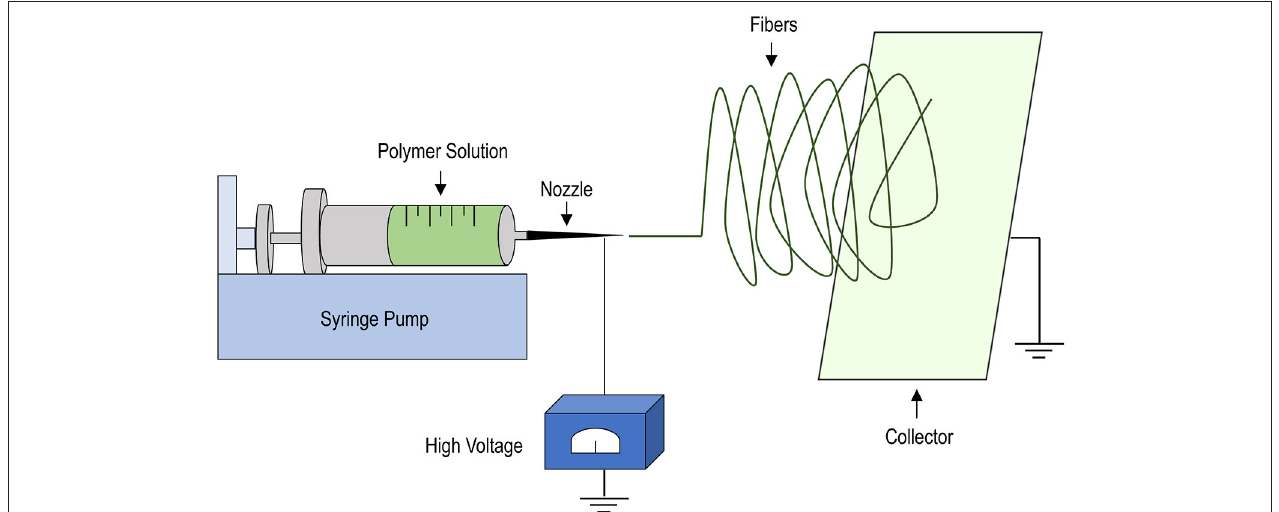
FIGURE 2 | Schematics of the electrospinning procedure. A liquid polymer solution is loaded into a syringe mounted into a syringe-pump and set to flow at defined rates through a nozzle of variable diameters (depending on the operational needs). The application of strong electric field allows the polymer to deposit onto a collector, consisting of a rotating mandrel or, as shown, a rotating plate onto which a non-woven scaffold can be manufactured due to solvent evaporation and solidification of the polymer fibers. Scaffold properties, such as porosity, fiber dimension and thickness can be easily adjusted by varying the dimension of the nozzle, the extrusion speed, the intensity of the electric field and the rotation speed of the